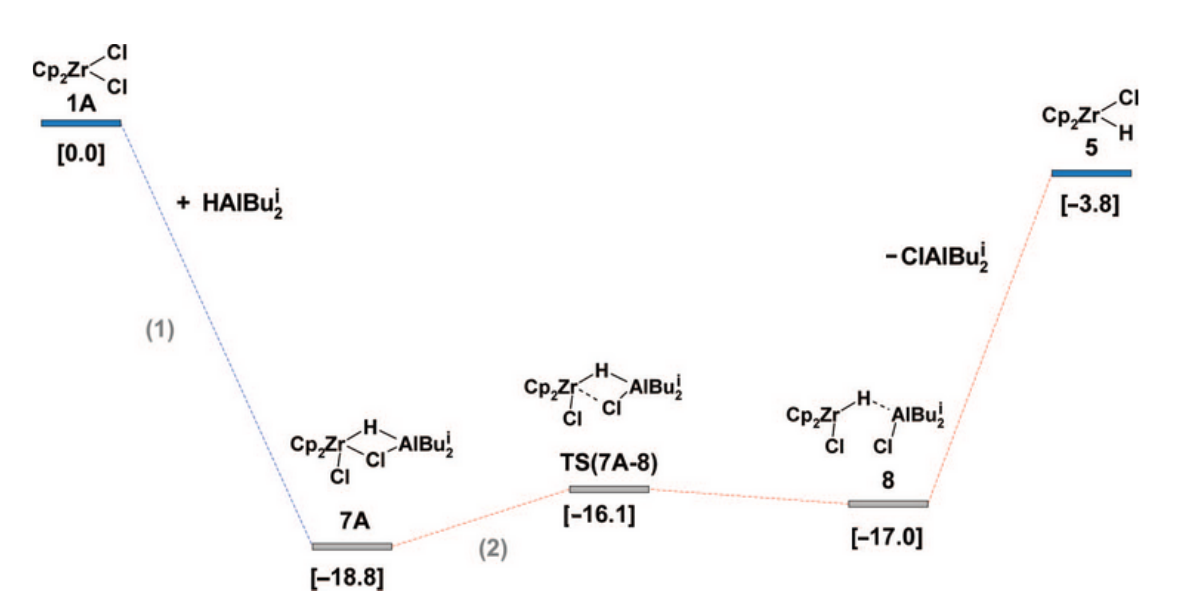
Figure 13. Energy profile of Cp 2 ZrHCl formation (reaction enthalpies in kcal · mol − 1 are shown in square brackets). Reprinted with permission from [135]. Copyright (2009) American Chemical